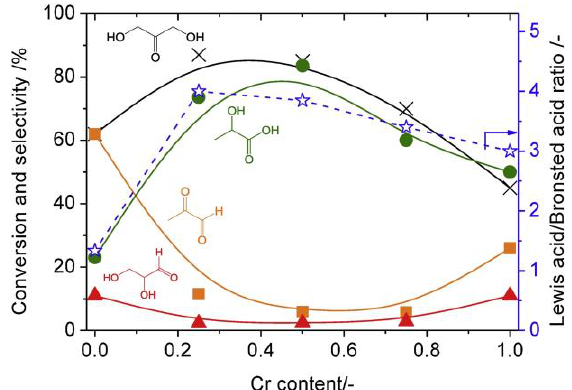
16 of 19 Figure 17. Two synergetic strategies converting glucose to HMF: (i) Glucose isomerization by cooperation between a Lewis acid and a proton donor (example systems are Sn/Beta and WO 3 ⋅ H 2 O) followed by fructose dehydration and (ii) stepwise glucose dehydration catalyzed by a Lewis acid-base pair (an example being Ti4c−O−Ti−OH on titania). Reproduced with permission from [44]; copyright (2018), John Wiley & Sons, Inc. 8. Supported Metal Oxides Supported catalysts are widely used for the chemical industry. The use of supports with high surface areas enables high dispersion of active species. The high atomic efficiency is preferable for the guideline of green chemistry. A variety of silica-supported metal oxides were investigated for lactic acid formation from trioses in water [46]. It was found that silica-supported chromia-titania catalysts selectively afforded lactic acid (80% yield) at 403 K. The co-impregnation of chromium oxide and titanium oxide formed